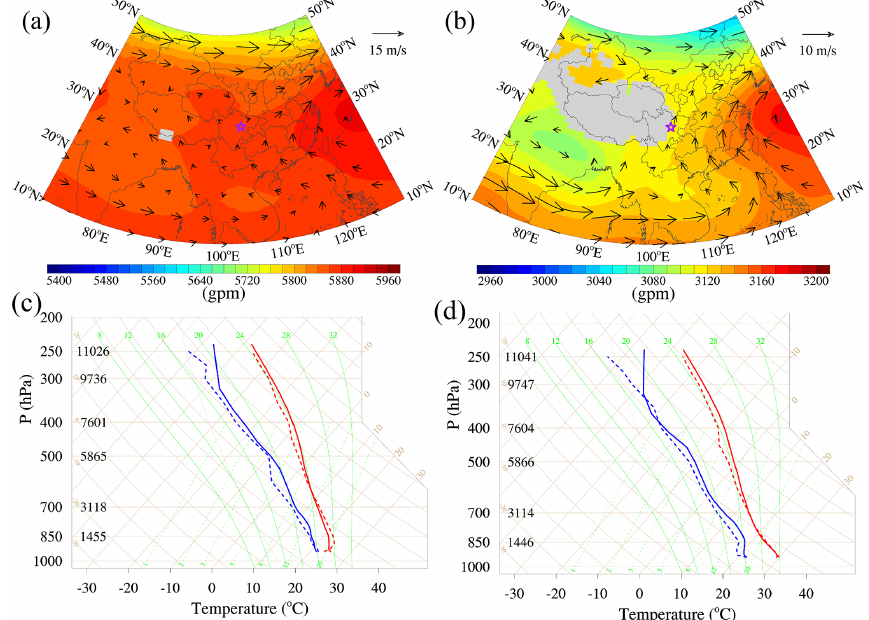
Figure 5. The weather charts at (a) 500hPa and (b) 700hPa for July 2017 are based on the NCEP FNL reanalysis data. The purple stars show the location of Chengdu. Panels (c) and (d) show the skew-T diagrams at 00:00UTC and 12:00UTC, respectively, in July 2017. The red and blue solid lines are the respective simulated air temperature and dew point temperature in the July_Base simulation, and the red and blue dashed lines are the respective sounding temperature and dew point temperature. These results are monthly